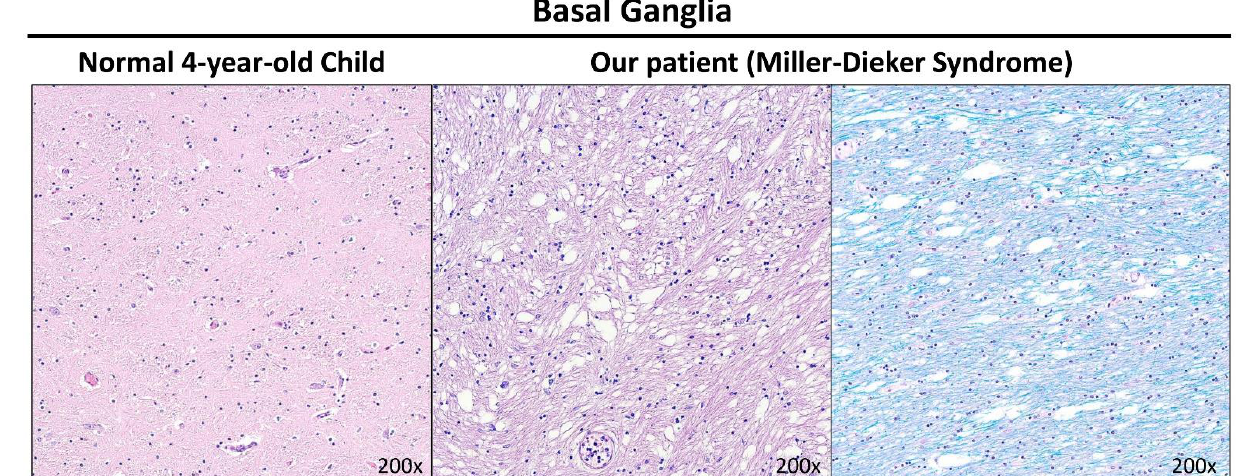
Figure 8. Microscopic images of the basal ganglia. Section of the basal ganglia stained with H&E showed extensive diffuse vacuolation of the white matter within the internal capsule ( Left panel ) compared to a normal 4-year-old child’s basal ganglia ( Right panel ). A Luxol Fast Blue (LFB) stain for myelin is accentuated in the vacuolated areas of the gray and white matter portions ( Right panel ) (200x magnification).